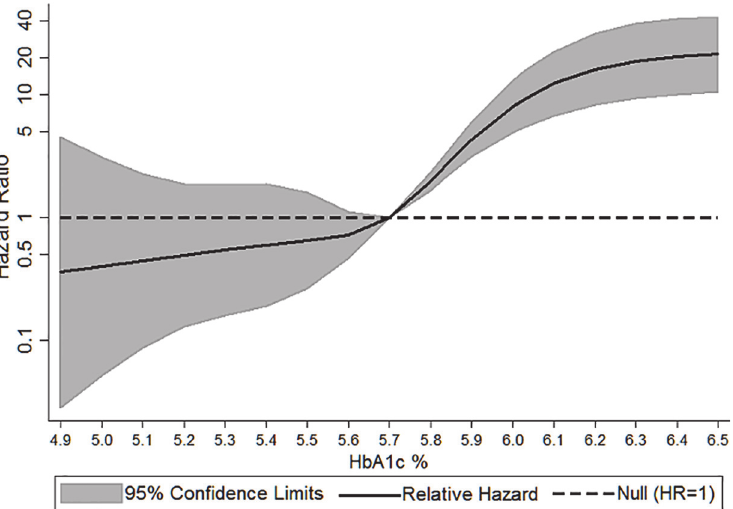
Fig 2. Cubic spline of the association between glycated hemoglobin (HbA1c %) and self-reported incident diabetes, adjusted for age, gender, and dialect, The Singapore Chinese Health Study. The hazard ratio (HR) is per each absolute increase of 1 percentage point in the glycated hemoglobin value at baseline. The shaded area is the 95% confidence interval from the restricted-cubic-spline model. The HR scale is logarithmic, the model is centered at the mean/median (5.7%), and the plot was truncated at the 5th and 95th percentiles of glycated hemoglobin (4.9% and 6.5%, respectively). The hazard ratio was adjusted for age, gender, and